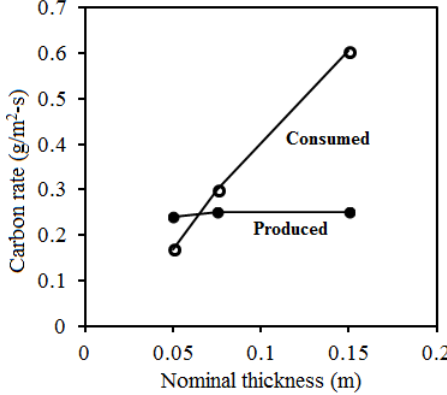
Figure 15. Carbon production rate vs. wall char layer thickness [51].